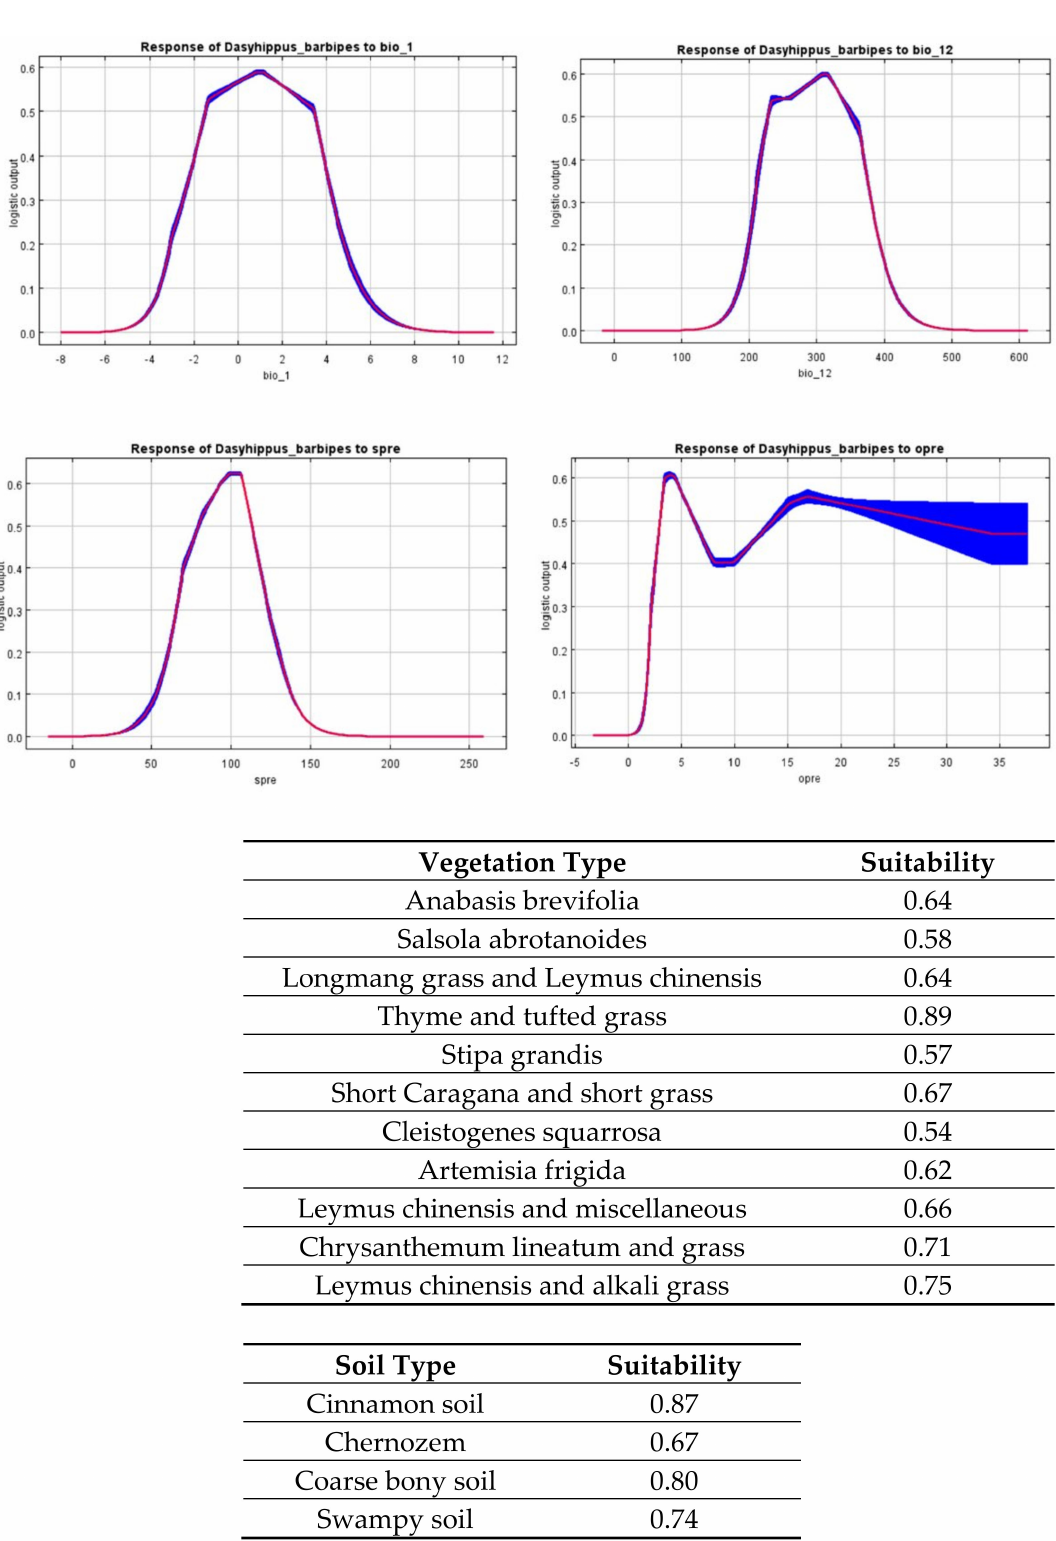
Figure 8. The response curves of the main habitat factors in our model prediction, showing the relationships between the probability of the occurrence of locusts and the habitat variables. The displayed values are the average of 10 repeated runs. The blue areas show the ± SD of the 10 repetitions. For each panel, the X axis represents the variable and the Y axis represents the probability of